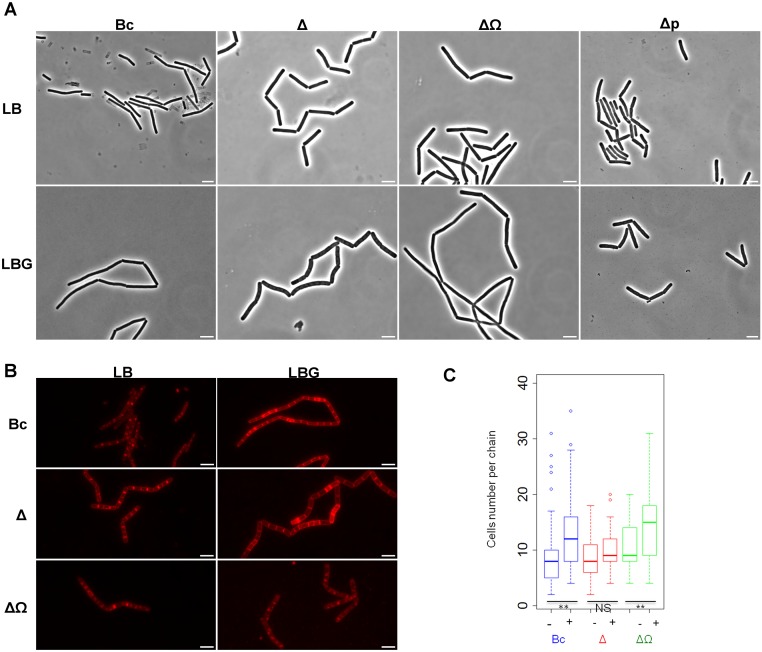
Chain lengths in Bc, ΔclhAB2, and ΔclhAB2ΩclhAB2 populations in the presence or absence of glucose.(A) Phase-contrast images of cell-chains at t0 of wild-type (Bc), ΔclhAB2 (Δ), complemented (ΔΩ) and pHT315 (Δp) mutant strains grown in LB medium and LB medium supplemented with glucose (LBG). Images of chains revealed strong constrictions (deeper invaginations) corresponding to cells undergoing separation. Scale bar (5μm) is shown for each image. (B) Fluorescent micrographs of Bc, Δ, and ΔΩ cell-chains at t0 in LB and LBG. Division septa and cytoplasmic membranes were imaged using the FM4-64 lipophilic dye. Scale bar (5μm) is shown for each image. (C) Box plots of chain length (number of cells per chain) at t0 in Bc (blue), ΔclhAB2 (red), ΔclhAB2ΩclhAB2 (green) populations. Between 90 and 130 chains from at least three independent cultures were analysed. No fewer than 1,000 cells were quantitated for each strain represented in the graph using fluorescence micrographs (see Materials and methods). Median (strong line in the box), interquartile range (IQR; box), whiskers (1.5 x IQR) and outliers (dot) are presented. Significance is based on two tests, Mann-Whitney and Two-Sample Fisher-Pitman Permutation, with a P of <0.01**. Non significative (NS), P> 0.05.